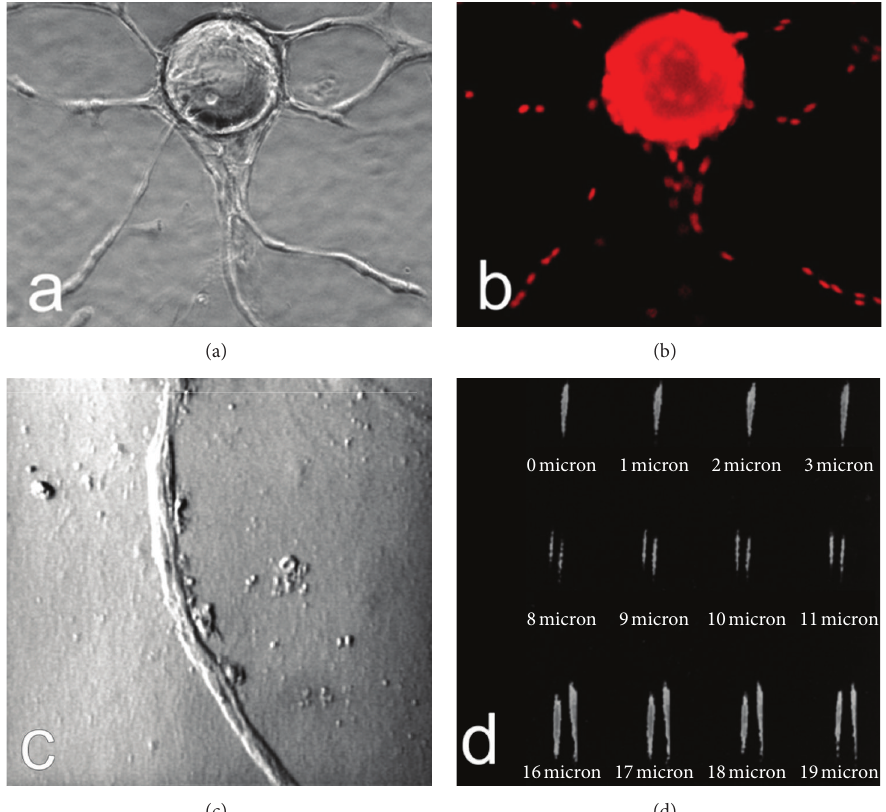
Figure 4: Presence of multiple cells in capillary tube-like structure by nuclei staining and presence of lumen demonstrated by confocal microscopic analysis. (a) HDMEC formed elongated and branched capillary sprouts in fibrin gel after 5 days in presence of VEGF (30ng/mL) and bFGF (25 ng/mL). (b) The culture in (a) was fixed and stained with propidium iodide (PI) to reveal nuclei. (c) Phase-contrast photo- micrograph of typical capillary tube-like structure formed by HDMEC in fibrin with VEGF (30ng/mL) and bFGF (25ng/mL). (d) Series of contiguous 1 micron thick tangential cross sections of the capillary tube-like structure, obtained by reflective confocal microscopy with computerized imaging, initially revealed the top of the tube (0–3 microns) and then the presence of a central lumen (8–19 microns) between two walls. (a) and (b) 100x and (c) and (d) 400x